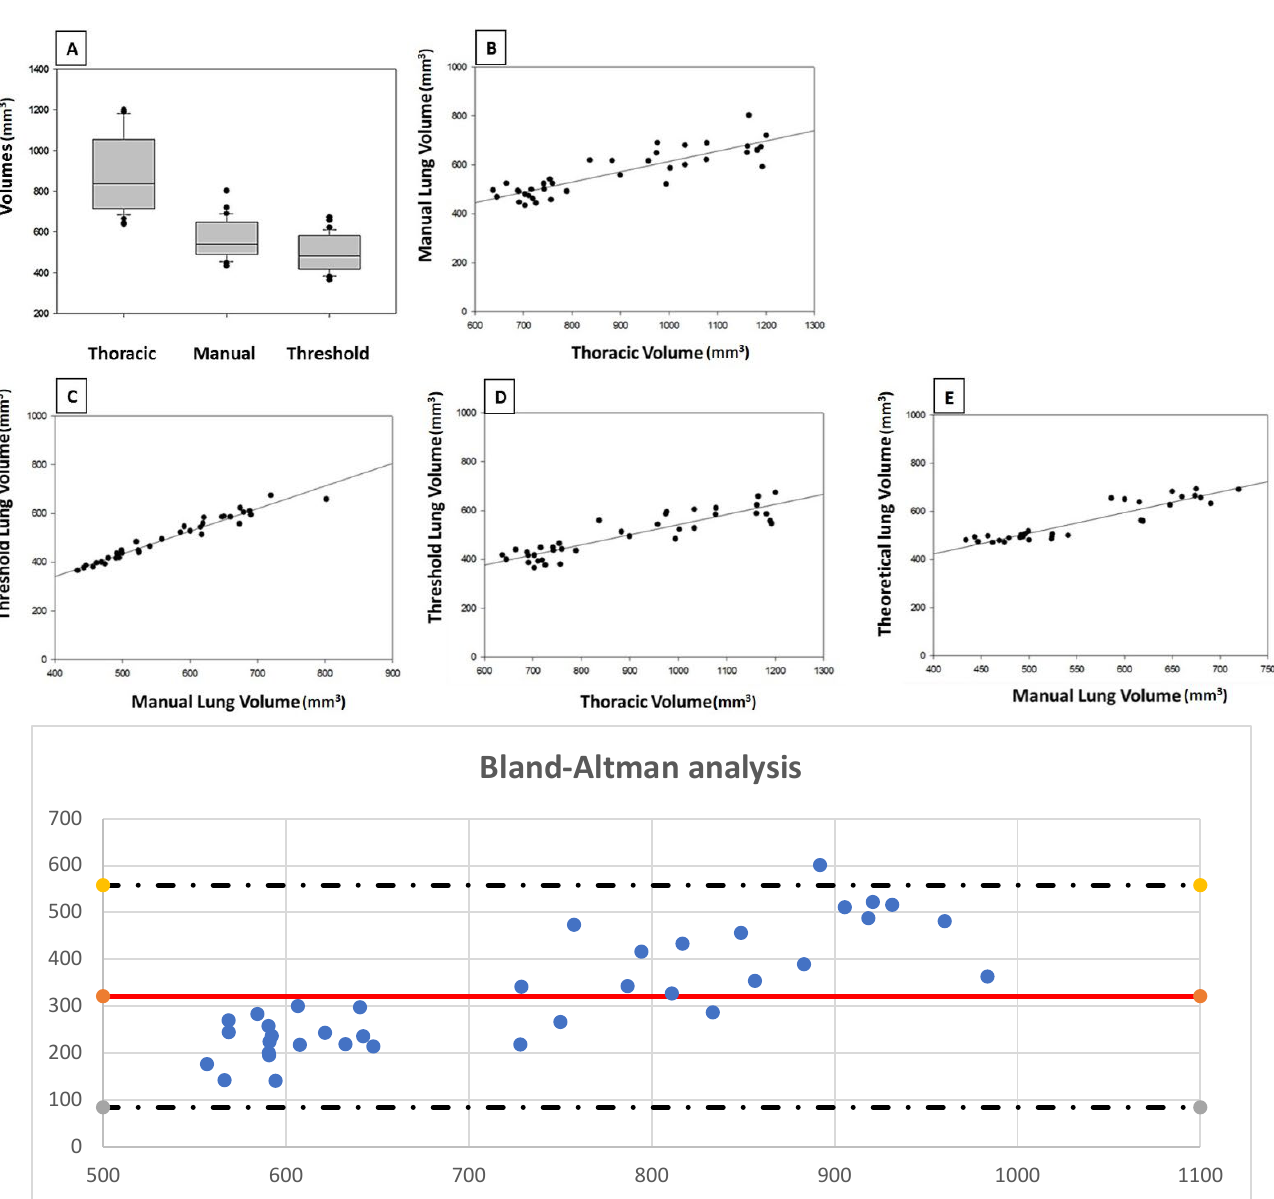
Figure 3. Thoracic, manually delineated and thresholded volumes from healthy mice group and Bland-Altman plot. ( A ) Distribution of mean values. ( B ) Correlation between thoracic and manually delineated lung volumes (R 2 = 0.7126). ( C ) Correlation between manual and threshold volumes (R 2 = 0.9526). ( D ) Correlation between thoracic and threshold lung volumes (R 2 = 0.6871). ( E ) Correlation between manually delineated lung volume and theoretical lung volume (R 2 = 0.8573). In all the cases, the correlation is statistically significant ( p -values shown in Table A3). At the bottom, the Bland-Altman plot, where all the points except one are included in the range of 95% of confidence for the theoretical volume minus gold standard volume. The x -axis shows the average measurement of lung volume using both methods while y -axis shows the difference between the theoretical lung volume and manually delineated lung volume. The red line represents the average difference in measurements.